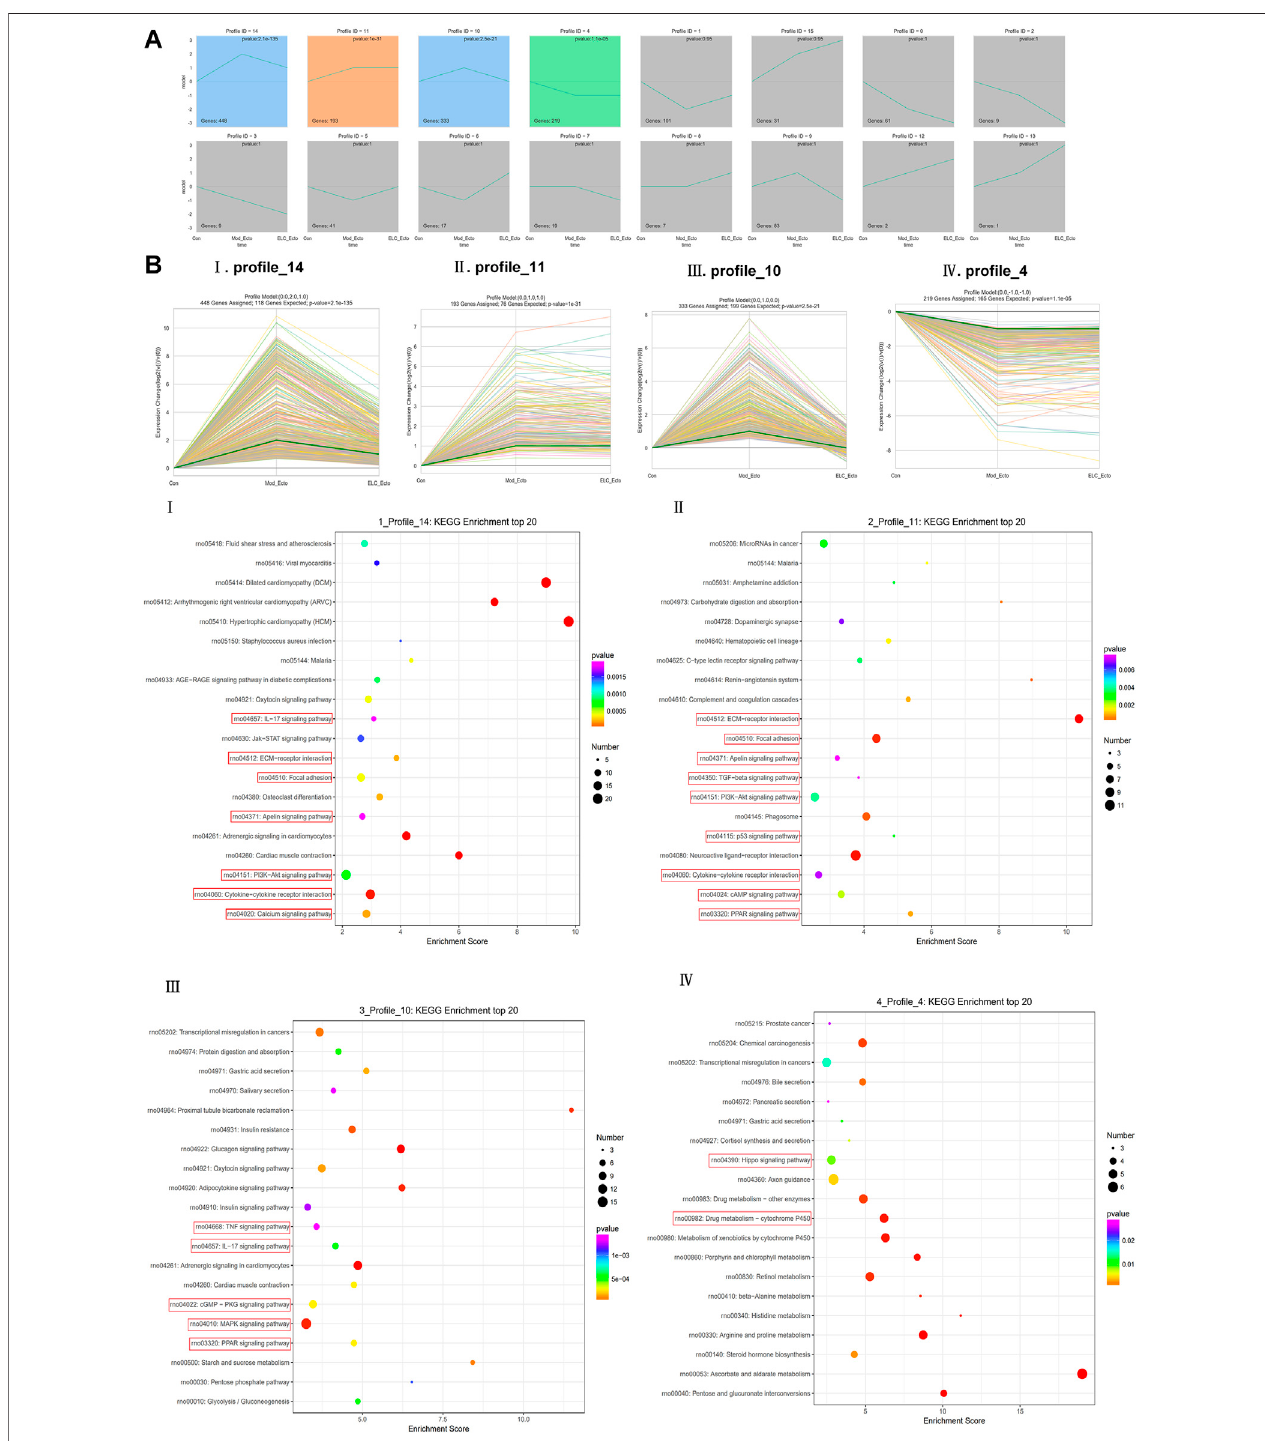
FIGURE 8 | STEM analysis of ELC treatment in endometriosis rats. (A) Trend chart of overall STEM analysis. (B) Four statistically signi fi cant trends. The results of gene cluster analysis were statistically signi fi cant in pro fi les 14, 11, 10, and 4 ( p < 0.05). The pro fi le_11 panel (Bii) and pro fi le_4 panel (Biv) could be the regulatory genes of endometriosis model development ( p < 0.05). The series test of the pro fi le_14 panel (Bi) and pro fi le_10 panel (Biii) showed that the signi fi cant clusters were considered potential pro fi les that could be affected by ELC treatment ( p < 0.05). (i) p (cid:2) 2.1E-135, (ii) P (cid:2) 1E-31, (iii) p (cid:2) 2.50E-21, and (iv) p (cid:2)